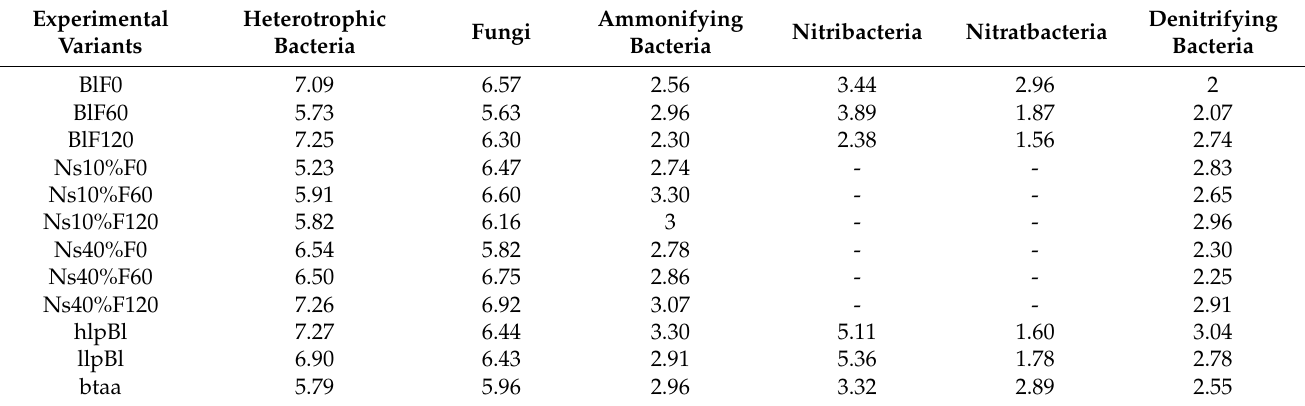
Table 1. Logarithmic expression of the number of microorganisms belonging to each microbial group studied (log cells/g dry